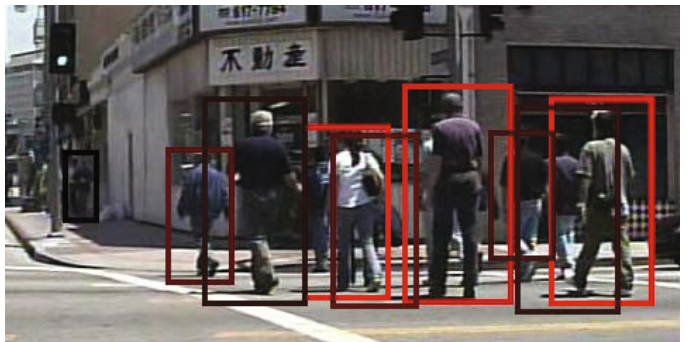
Figure 3. Example of pedestrian detection on an image from Caltech-USA test set by using a method SquaresChnFtrs. Reprinted/Adapted with permission from Ref. [18]. 2015 Springer